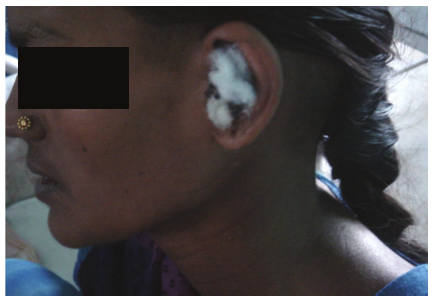
Figure 4: Photograph of the patient at discharge with no neck